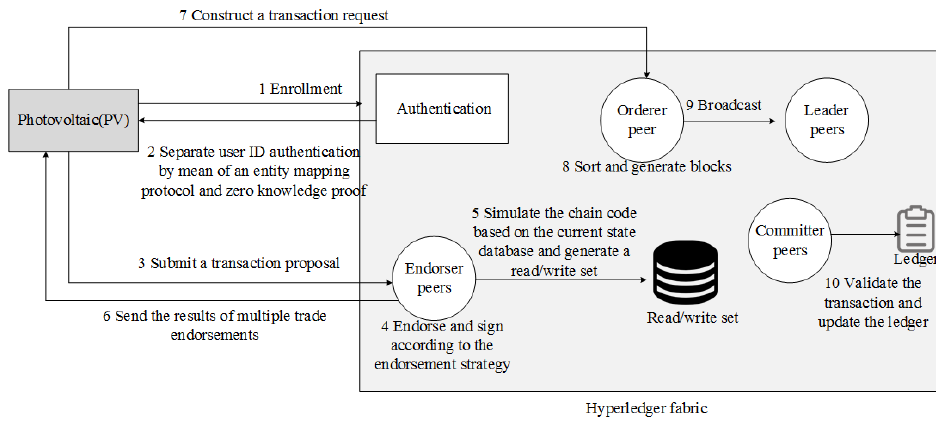
Figure 32. Reconstruction diagram of reference [62].